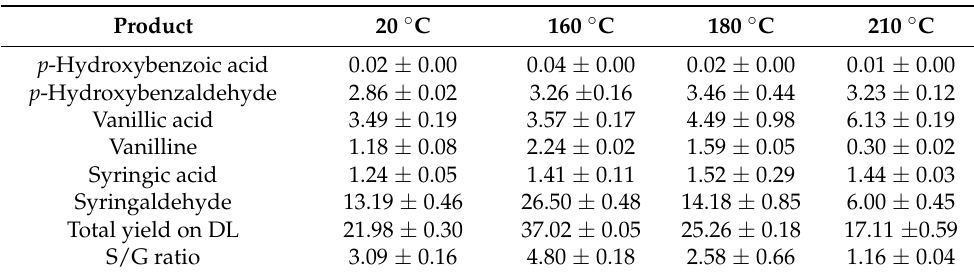
Table 4. Phenolic aldehydes and acids from nitrobenzene oxidation of merbau dioxane lignins (mean ± SD, %).